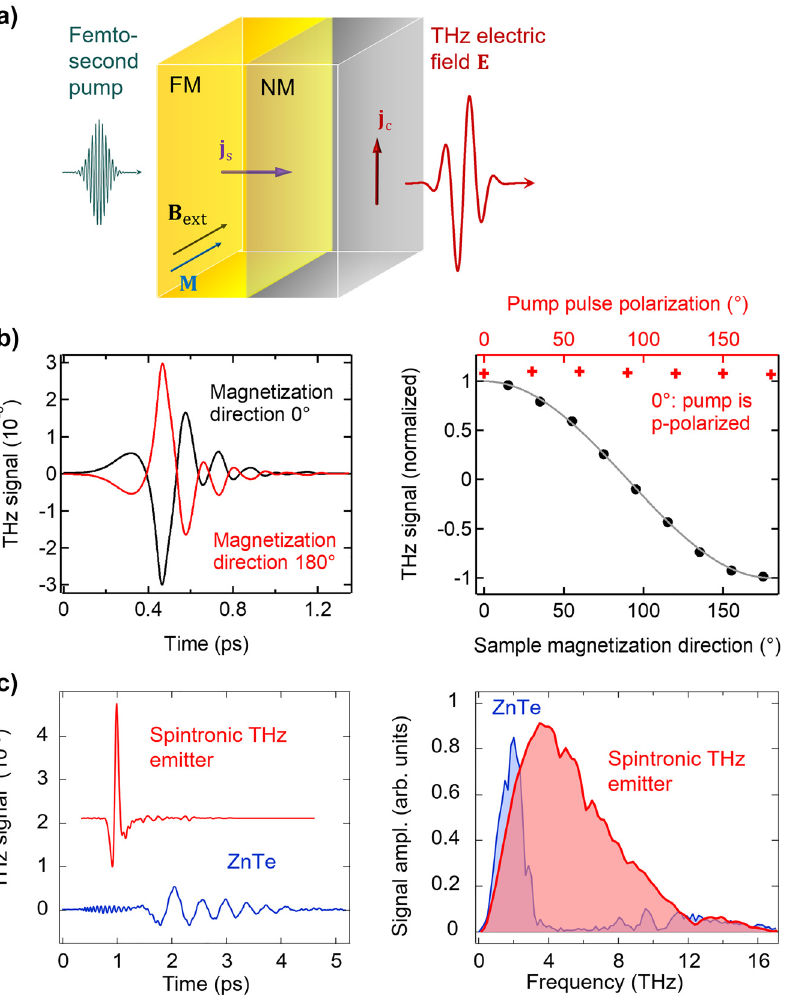
Figure 12: (a) Schematic of a spintronic terahertz emitter (STE). A femtosecond pump pulse drives terahertz spin transport from the ferromagnetic (FM) into the nonmagnetic (NM) metallic layer. The spin polarization of the resulting out-of-plane spin current j s is determined by thein-planesamplemagnetization M ,whichissetbytheexternalmagnetic fi eld B ext .Spin-to-charge-currentconversion(S2C),predominantlyby the inverse spin Hall effect, converts into an in-plane charge current j c , which emits a terahertz pulse with transient electric fi eld E . (b) Terahertz signal symmetries. Impact of opposite sample magnetizations (left panel) and of the pump polarization (right panel, red symbols) and the in- plane samplemagnetization orientationon theemitted terahertz-pulsepolarization (blacksymbols). (c) Typical terahertzsignalwaveforms and their spectra as obtained from an STE and a conventional ZnTe terahertz emitter under identical conditions. The waveforms were detected by electroopticsamplingina70µmthicksensormadeofLemke/amorphouspolycarbonate.Reprinted(adapted)bypermissionfrom[56].Copyright (2016) by Springer